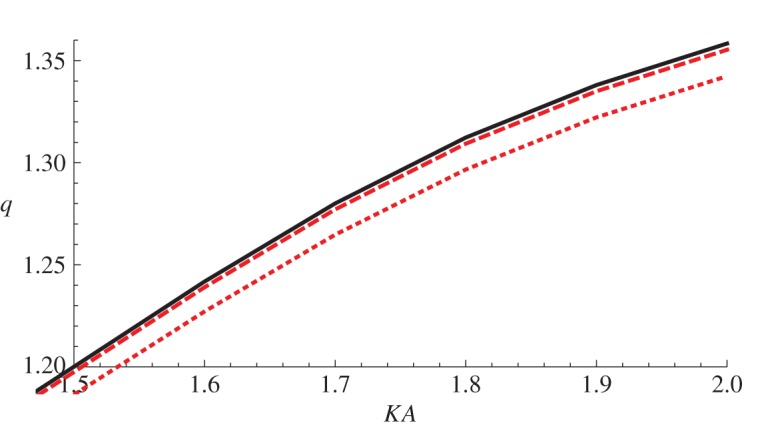
An enlarged version of the region 1.5≤KA≤2, 1.2≤q≤1.36 displayed in figure 4.